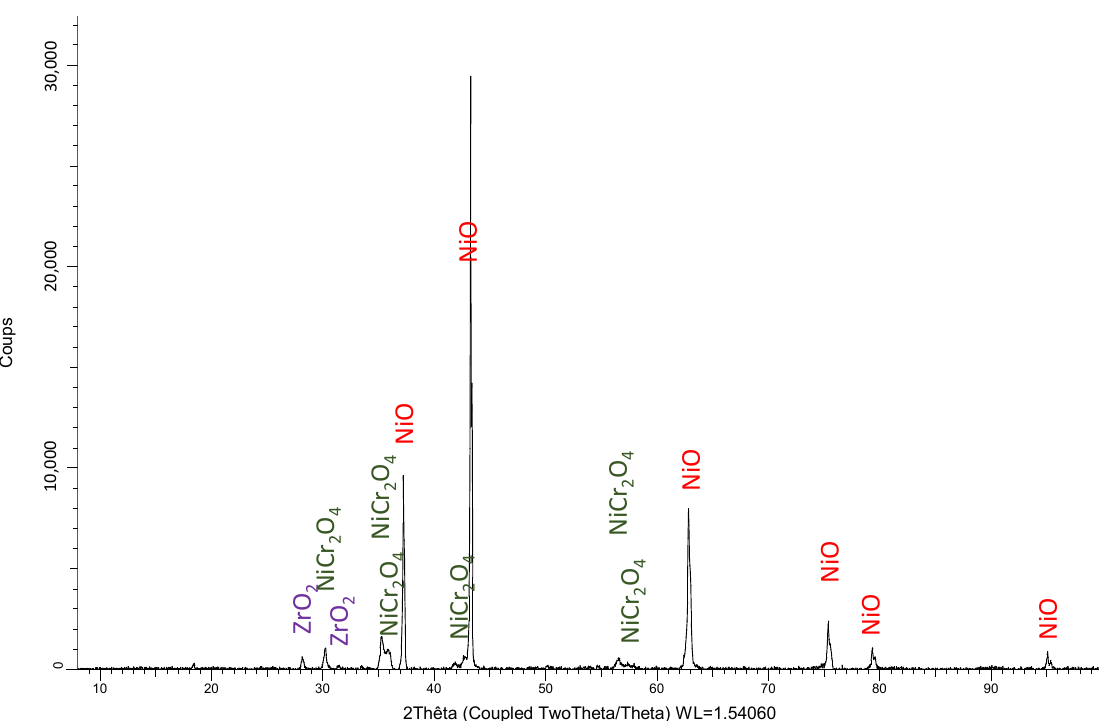
Figure 7. Diffractogram acquired on the oxidized surface of the Ni–25Cr–0.50C–3.8Zr sample.